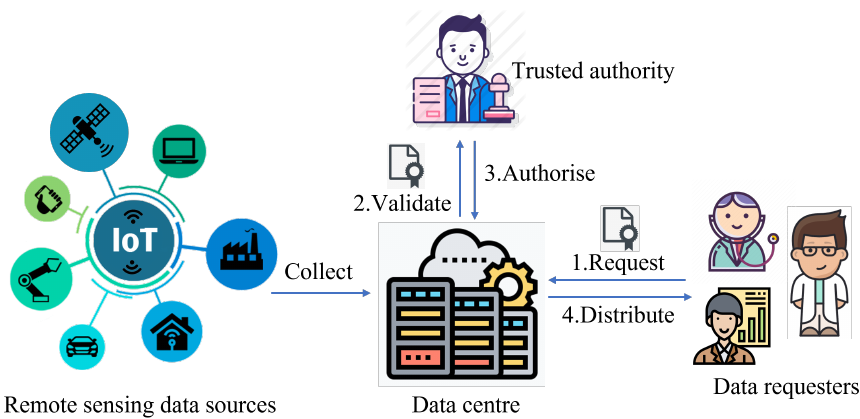
Figure 1. The system model of